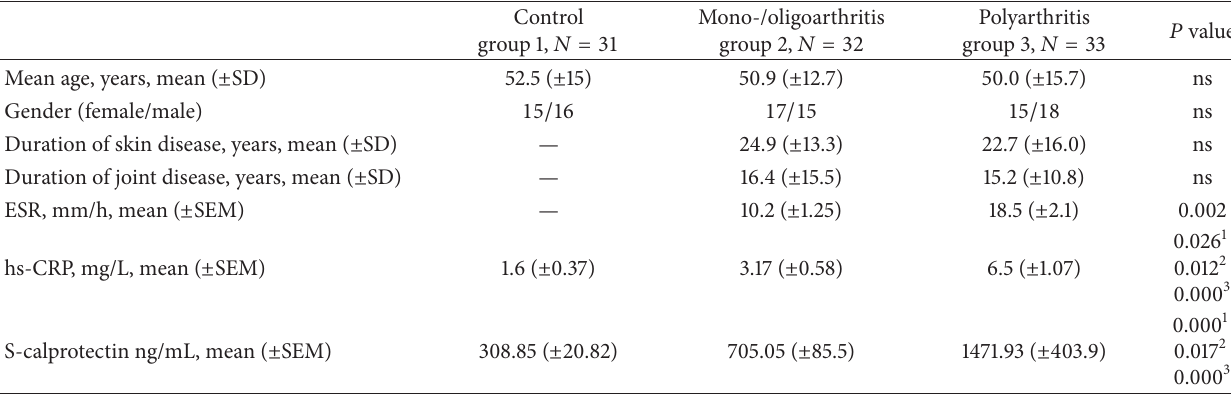
Table 1: Characteristics of patients and controls.